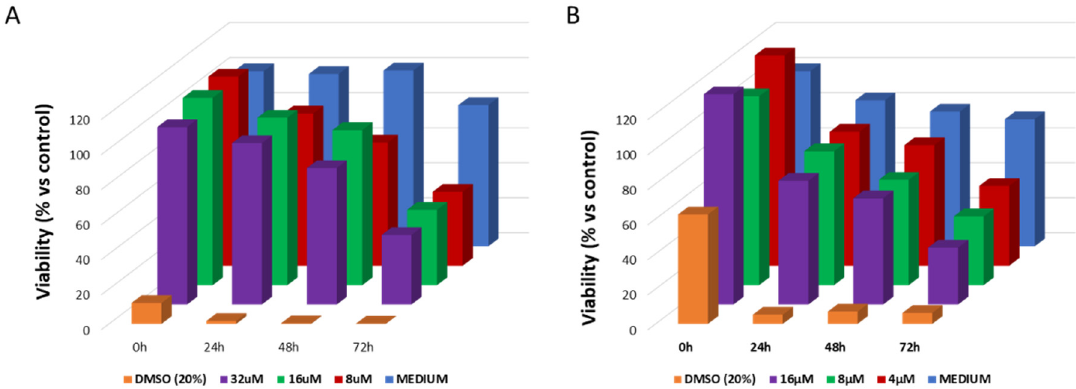
Figure 3. Cytotoxic effect of cisplatin-loaded nanoparticles on 3D models of HNSCCs. Cells of ( A ) SCC-25 and ( B ) UPCI:SCC-154 were treated with increasing concentration of NAs-CisPt. Spheroids without any treatments (MEDIUM) and treated with a solution of Dimethyl Sulfoxide 20% v / v (DMSO) were used as negative and positive controls, respectively. Cytotoxicity was monitored from 0 h to 72 h using the CellTiter-Glo ® 3D Cell Viability Assay. Results are the average of three independent experiments (error bars are resumed in Tables S3 and S4). Two-way ANOVA Dunnett’s test vs. MEDIUM, no significant statistical differences were found.